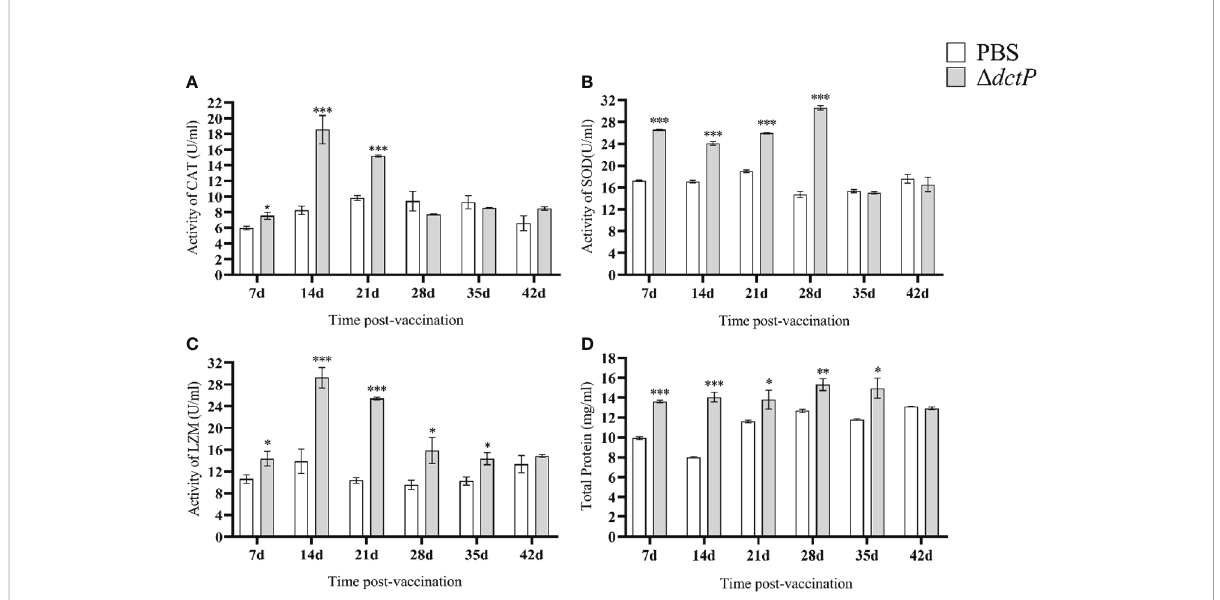
FIGURE 8 CAT, SOD, LZM activity and total serum protein in serum of pearl gentian groupers at 7d, 14d, 21d, 28d, 35d and 42d post-vaccination. (A) CAT activity; (B) SOD activity; (C) LZM activity; (D) total serum protein. Bars represented the mean relative expression (n = 3) and error bars represented standard errors. The asterisks indicated signi fi cant differences: *(p < 0.05), **(p < 0.01) and ***(p < 0.001), between PBS group and D dctP